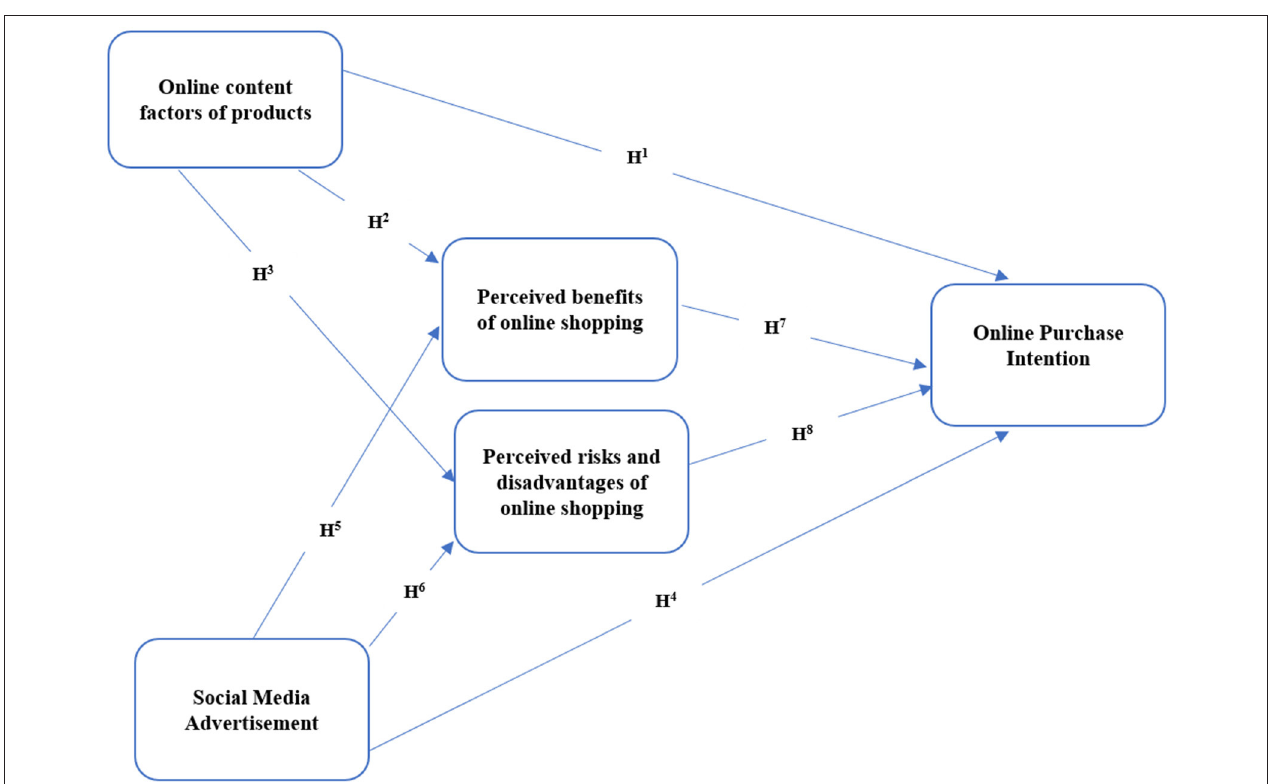
FIGURE 1 | Theoretical framework of the